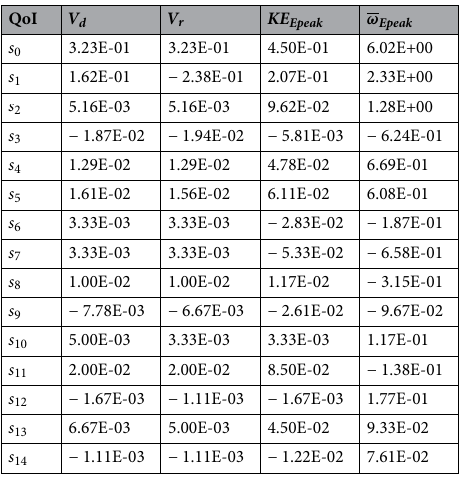
Table 2. PCE coefficients for each